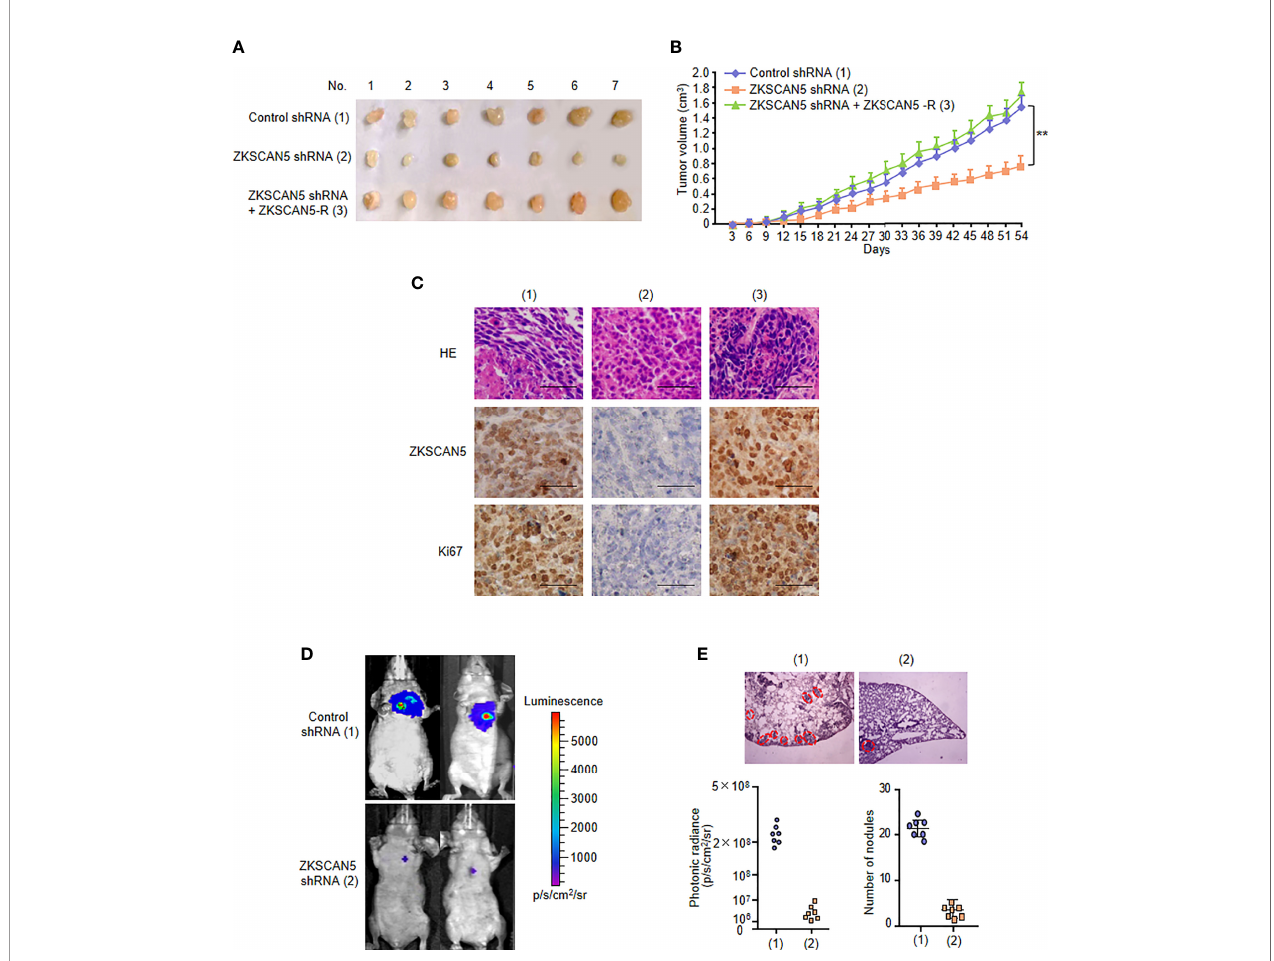
FIGURE 3 | ZKSCAN5 regulates the growth of breast cancer tumours and lung metastasis in vivo . (A, B) ZR75-1 cells stably infected with the lentivirus carrying the indicated constructs were injected subcutaneously into the nude mice (n = 7 per group). The tumour volume was measured every 3 days, and the growth curve was plotted (B) . (C) Representative IHC staining of ZKSCAN5 and Ki67 and H&E staining images of tumours resected from nude mice. Scale bar, 50 µm. (D) MDA-MB- 231 cells stably expressing the constructs were injected through the tail vein to construct a breast cancer cell metastasis model in nude mice (n = 7 per group). (E) Anatomical and histological analyses of representative lung metastases were carried out. The number of tumour tubercles was determined under an anatomical microscope. Symbols represent individual mice. **p < 0.01 versus the corresponding